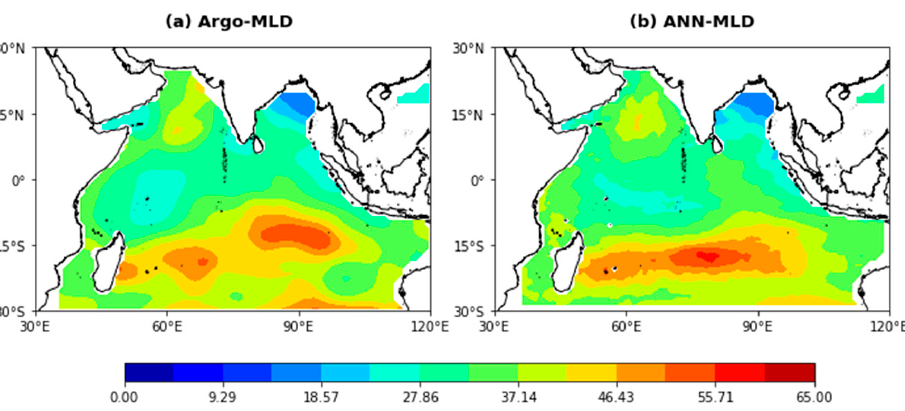
Figure 6. Annual mean MLD in the Indian Ocean estimated from ( a ) Argo data and ( b ) a pre- clustering ANN model in 2019.